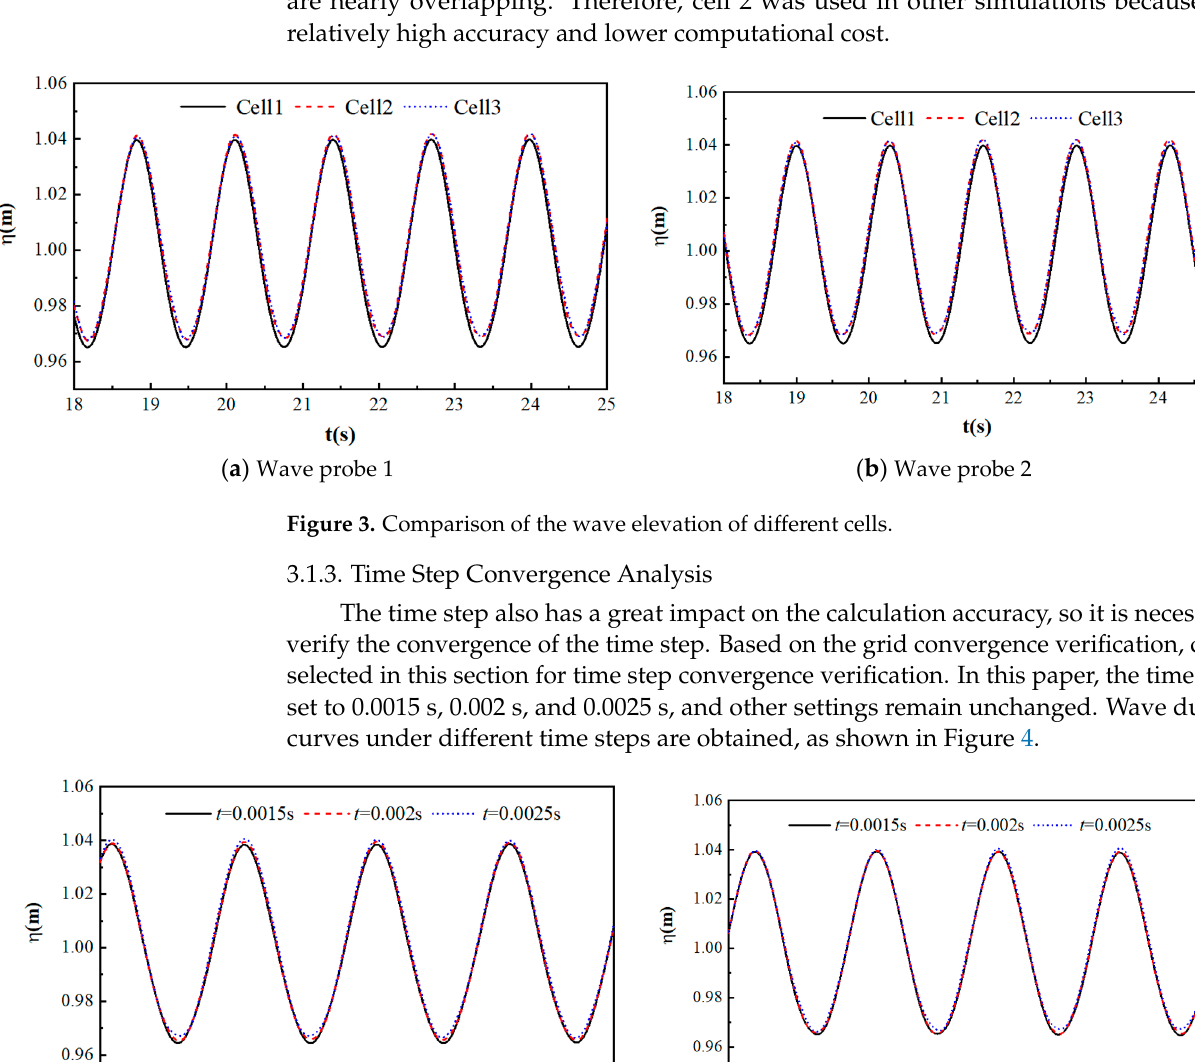
Table 1. Mesh parameters.